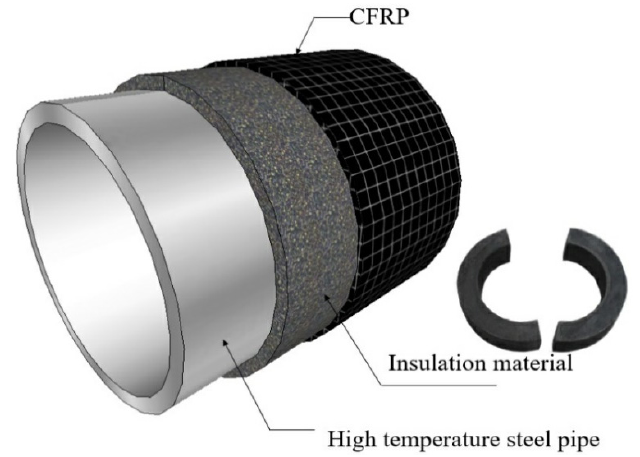
Figure 1. The strengthening method for the high-temperature steel pipelines.